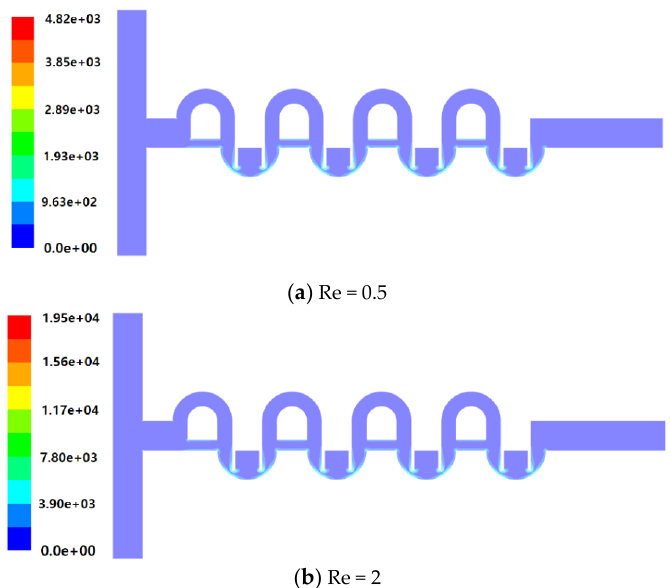
Figure 12. Distribution of vorticity magnitude on the plane of the channel half width z = 60 µ